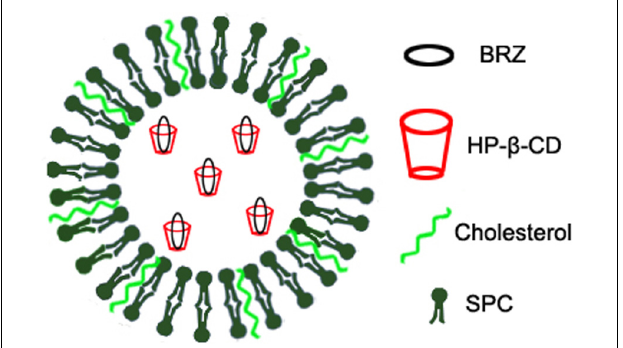
FIGURE 1 | Schematic structure of HP- β -CD/BRZ-inclusion complex loaded